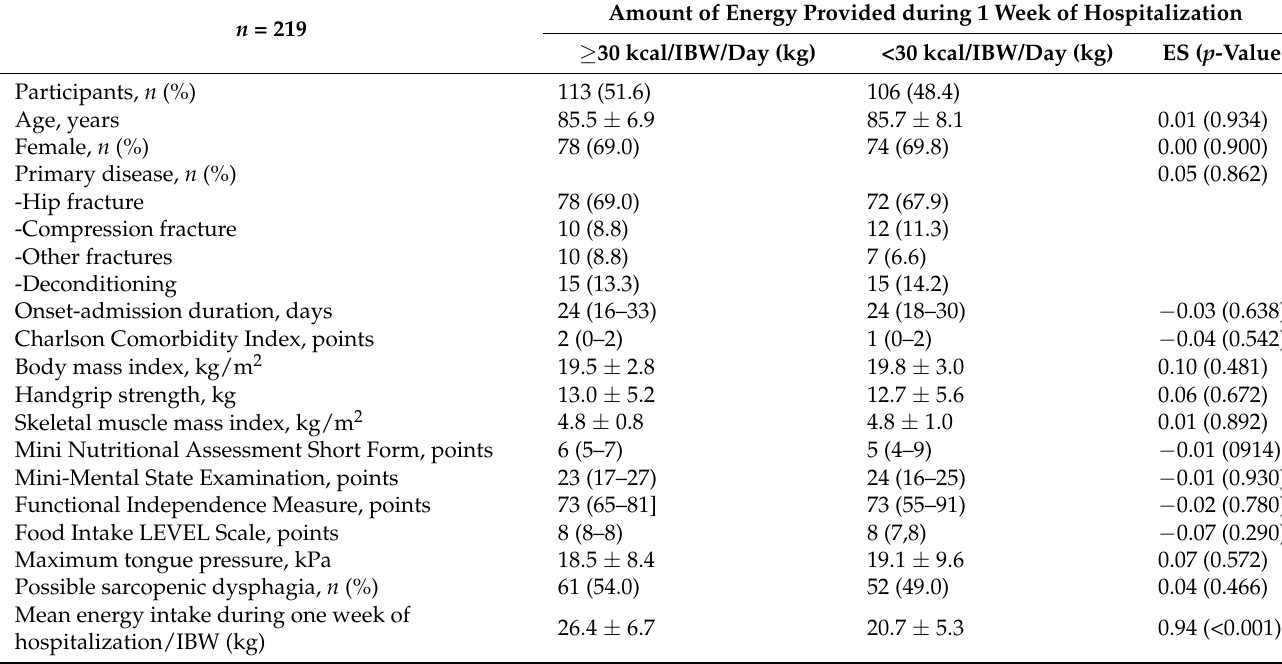
Table 2. Comparison of baseline variables in the inverse probability of treatment weighting (IPTW) model.